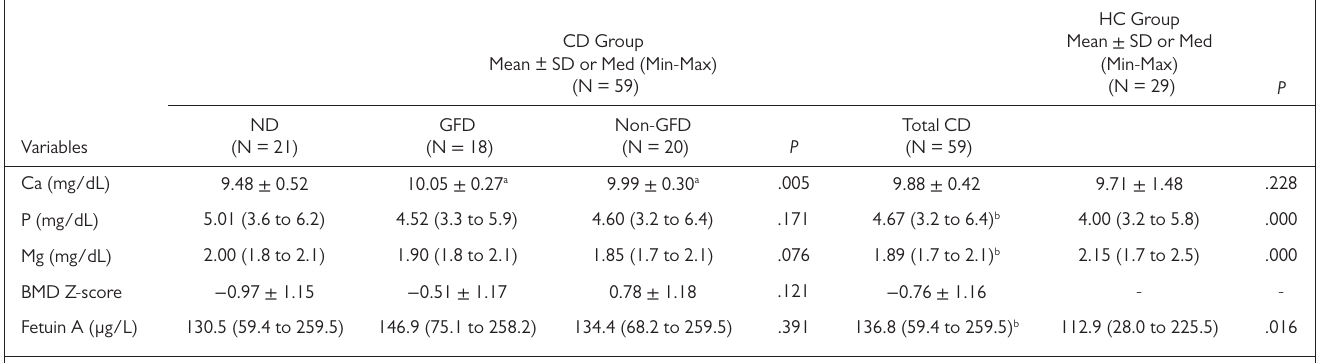
Table 2. Mineral, BMD, and Fetuin-A Data of Study Groups